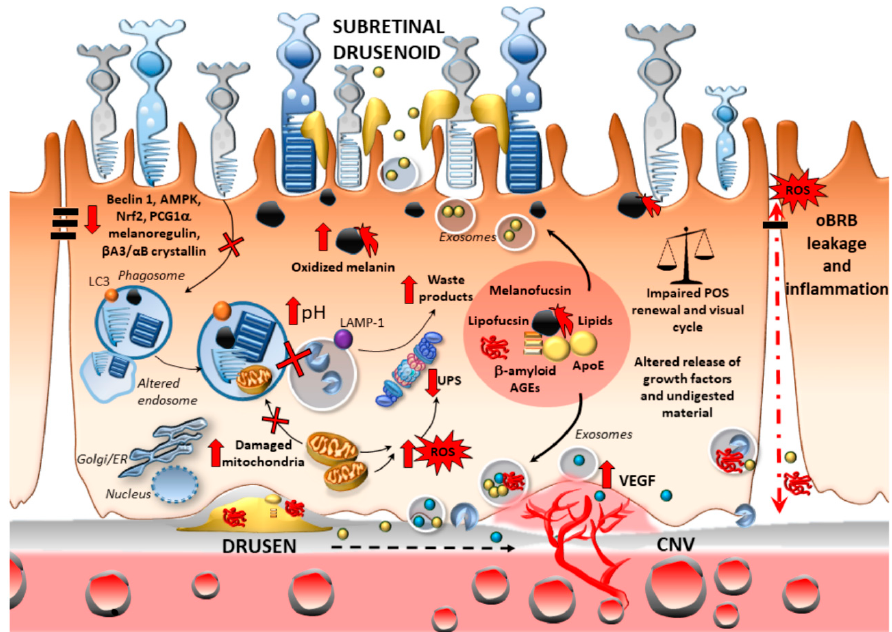
Figure 3. Autophagy and proteasome failure within RPE cells may foster AMD onset and progression. In aged RPE cells, impaired heterophagy due to the downregulation of Beclin 1, AMPK, Nrf2/PGC1a, melanoregulain, and crystallin co-chaperones occludes the digestion of the outer segments of photoreceptors, thus promoting the accumulation of damaged mitochondria and oxidized substrates such as lipofuscin and melanin. This further sensitizes RPE cells to light-induced oxidative stress, proteasome impairment, and protein misfolding. This goes along with an altered polarity of RPE cells due to abnormal, exosomal secretion of waste products (melano-lipofuscin, AGEs, oxidized lipids, and beta-amyloid), growth factors (VEGF and crystallins), and cathepsin D at either RPE sides. These events eventually contribute to impairing the visual cycle and photoreceptor’s metabolism, while promoting the formation of drusen and / or subretinal drusenoid deposit, the leakage of the outer blood–retinal barrier (oRBR), the recruitment of inflammatory mediators, and, eventually, CNV and angiogenesis fostering transition from dry to wet